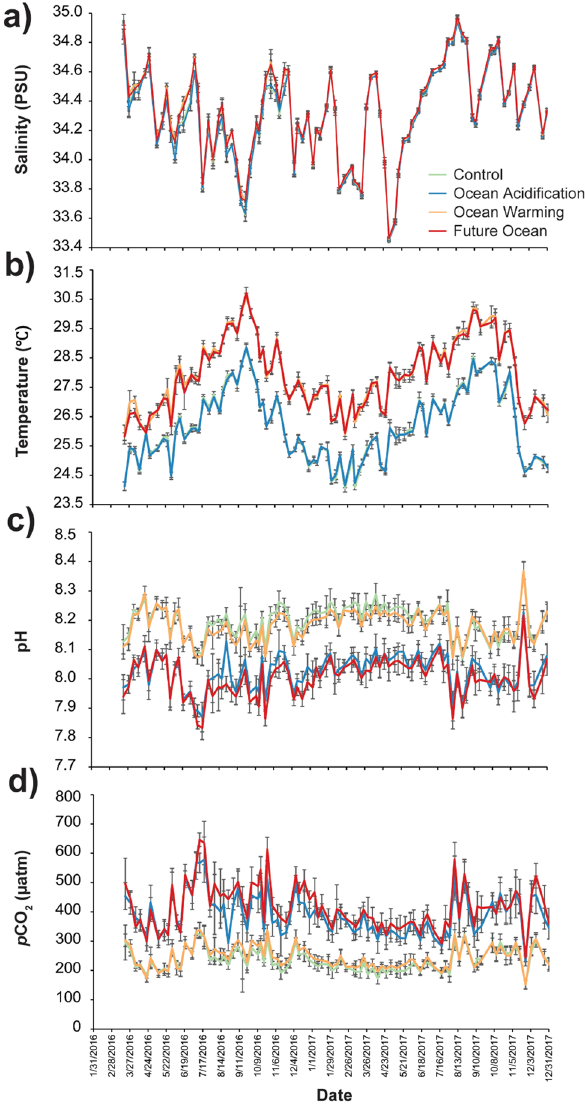
Figure 3. Weekly mean ± 1 SD mid-day (12:00) ( a ) salinity, ( b ) temperature, ( c ) pH, and ( d ) p CO 2 in each experimental treatment: control (green), ocean acidification (blue), ocean warming (orange) and combined future ocean (red) throughout the 22-month experimental period. Dates provided as